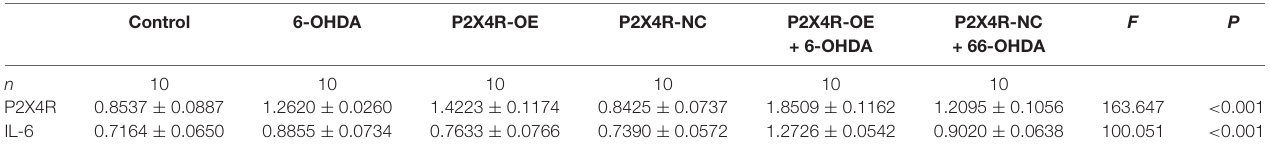
TABLE 2 | Expression of P2X4R and IL-6 in the substantia nigra (SN) of rats in six groups.